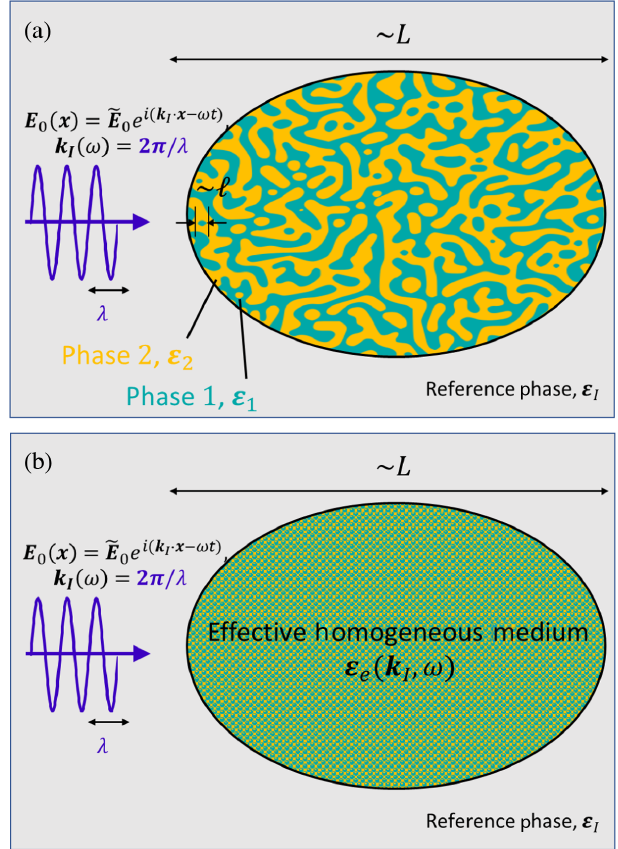
FIG. 2. (a) Schematic of a large d -dimensional ellipsoidal, macroscopically anisotropic two-phase composite medium em- bedded in an infinite reference phase of dielectric constant tensor ε (gray regions) under an applied electric field E 0 ð x Þ ¼ I ˜ E ( i ð k · x − ω t Þ ) of a frequency ω and a wave vector k 0 exp I I at infinity. The wavelength λ associated with the applied field can span from the quasistatic regime ( 2 π l = λ ≪ 1 ) down to the intermediate-wavelength regime ( 2 π l = λ ≲ 1 ), where l is a characteristic heterogeneity length scale. (b) After homogeniza- tion, the same ellipsoid can be regarded as a homogeneous k ; ω Þ , which specimen with an effective dielectric constant ε e ð I depends on ω and k . As noted in the main text, we omit the ω I dependence of ε because (without loss of generally) we assume a e linear dispersion relation between j k and ω I j